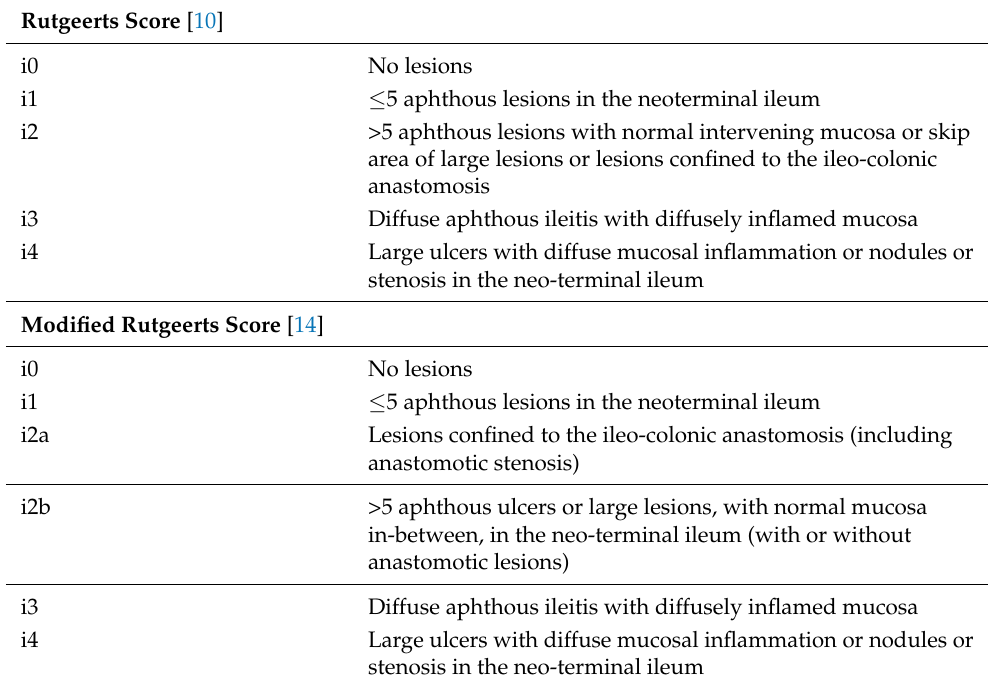
Table 1. Endoscopic indices used for the assessment of postoperative Crohn’s disease.